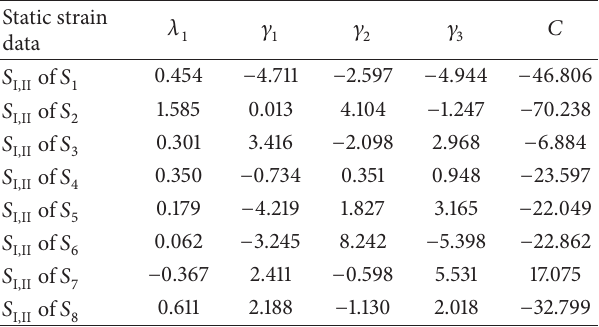
Table 2: Performance parameters 𝜆 1 , 𝛾 1 , 𝛾 2 , 𝛾 3 , and 𝐶 in correlation